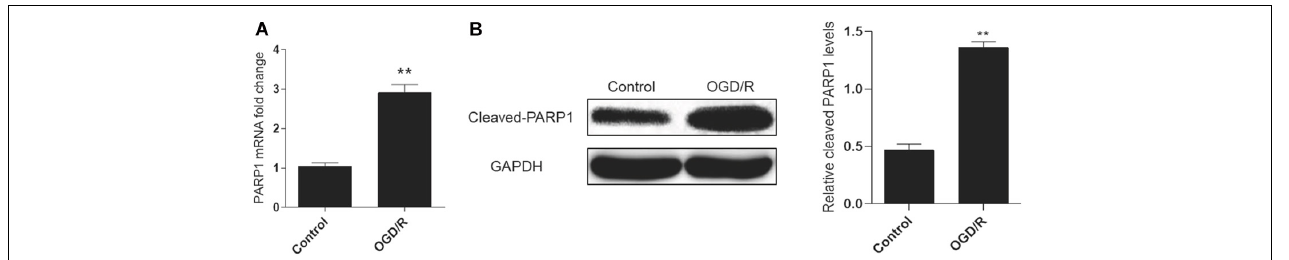
FIGURE 1 | PARP1 was activated by OGD/R-induced myocardial autophagy. H9c2 cells were cultured in an oxygen/glucose-deprived incubator for 6 h, and then reperfused by oxygen and glucose for 2 h to cultivate an OGD/R model. (A) Real-time PCR showed the mRNA level of PARP1 increased when H9c2 cells were exposed to OGD/R. (B) Western blot showed the protein level of PARP1 also rose when H9c2 cells were exposed to OGD/R. Compared with control group, ** P < 0.01. N = 4 for each group.